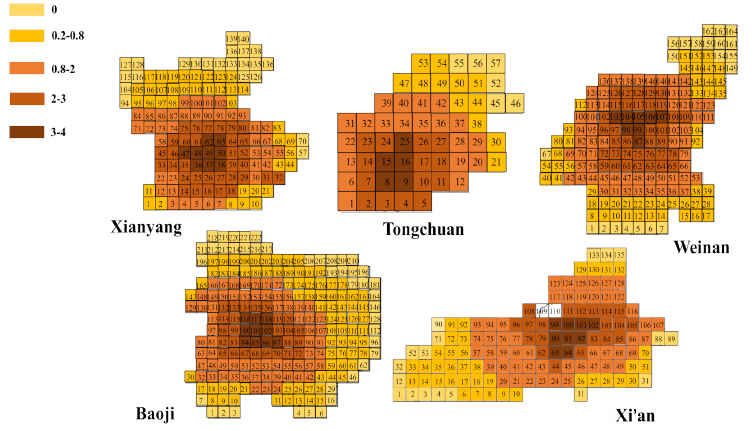
Figure 6. Distribution of the VOCs aggregation pattern in the regional grid at 14:00 (t = 134) on